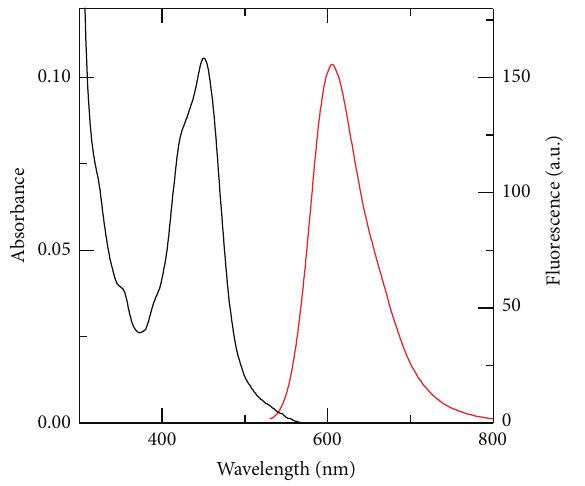
Figure 3: Absorption (black) and fluorescence (red) spectra of Ru- dye (1.1 × 10 −5 M) in ethanol.